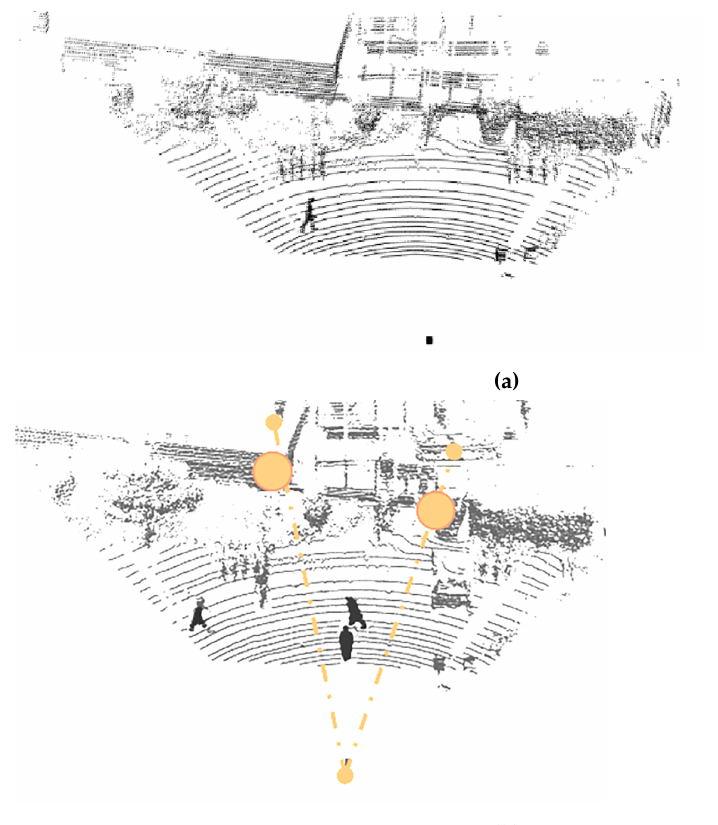
Figure 6. The “drilling” strategy in data augmentation through visibility reasoning: ( a ) the raw point cloud; ( b ) the point cloud after ground truth database sampling. The orange part will be removed after